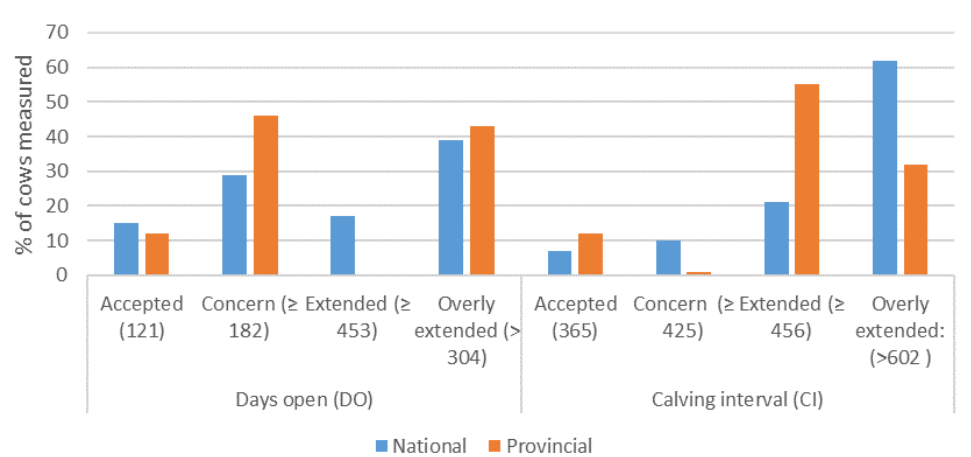
Figure 3. Measures of DO and CI levels in beef cattle farms at national and provincial level. DO and CI are recorded in days. The blue bar = DO and CI at national level and the orange bar = provincial level.